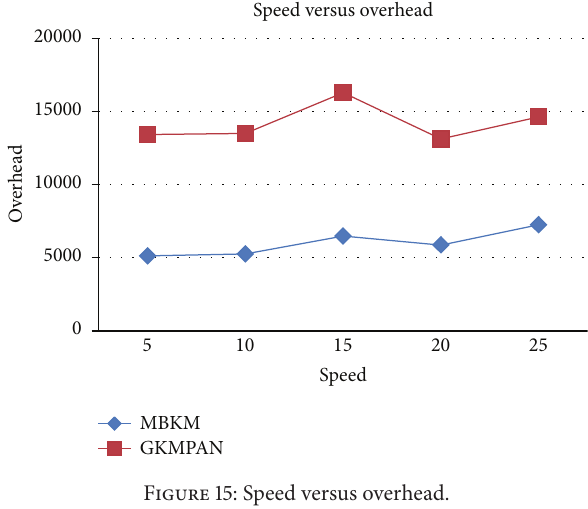
Figure 15: Speed versus overhead.